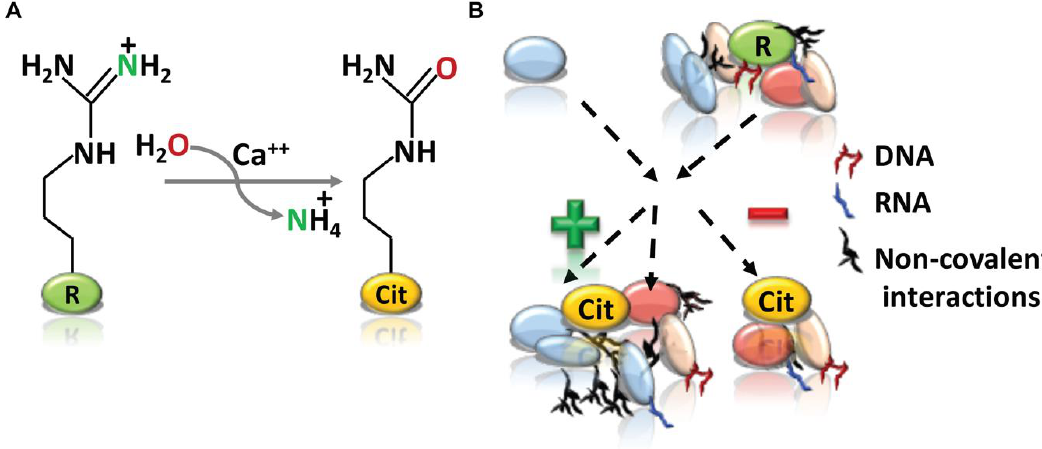
Figure 1. Arginine citrullination and its cellular functions. ( A ) The peptidyl arginine deiminases (PADI) enzyme catalyze peptidyl-arginine (positively charged) to peptidyl-citrulline (neutral in charge) and release of ammonia. ( B ) Arginine (green) to citrulline (orange) conversion could consequently affects the functional protein-protein and protein-nucleic acid interactions by affecting the protein folding, as well as intermolecular and intramolecular interactions. “ + ” and “ − ” signs representing the positive and negative interactions respectively.